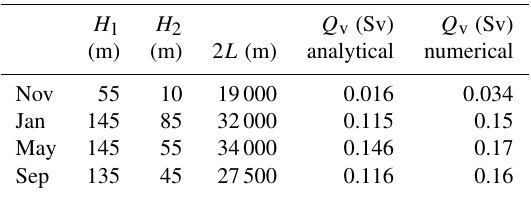
Table 3. The model deep flow boundary current parameters (1Sv = 10 6 m 3 s − 1 ) for different months. The last column shows direct cal- culations from the numerical